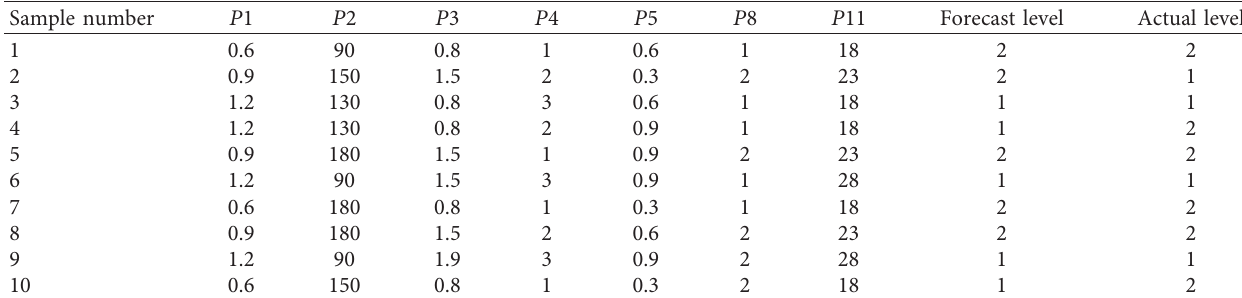
Table 5: NRS-RF model RFID system identification rate level